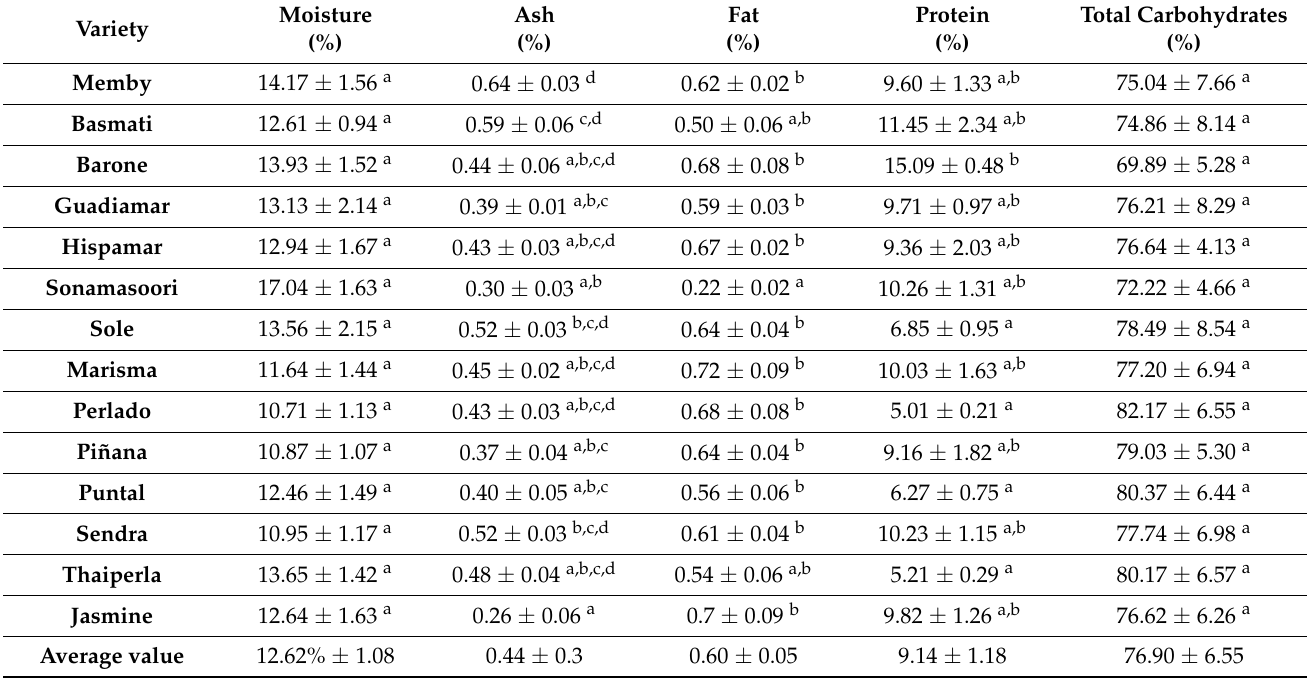
Table 6. Chemical composition of 14 major varieties of raw rice consumed in